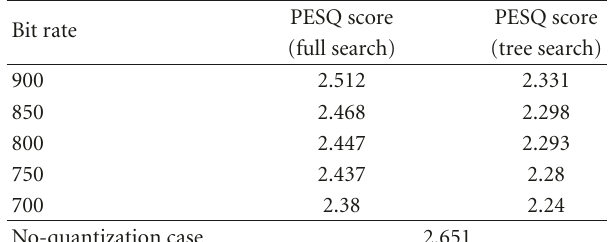
Figure 8: MUSHRA score at three di ff erent rates. Scores of 38, 40, 43 are achieved for 700, 800, and 900 bps, respectively. Table 5: PESQ scores at di ff erent